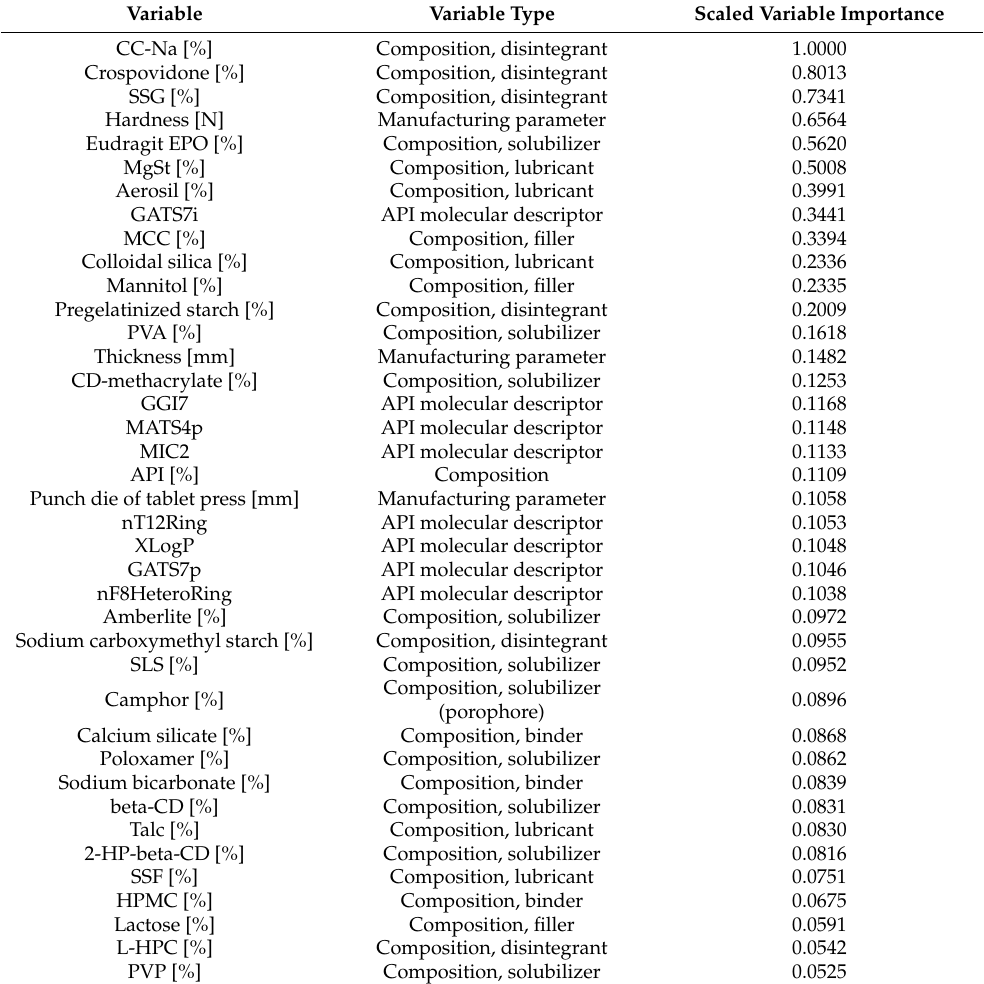
Table 4. Selected input vector for the best predictive